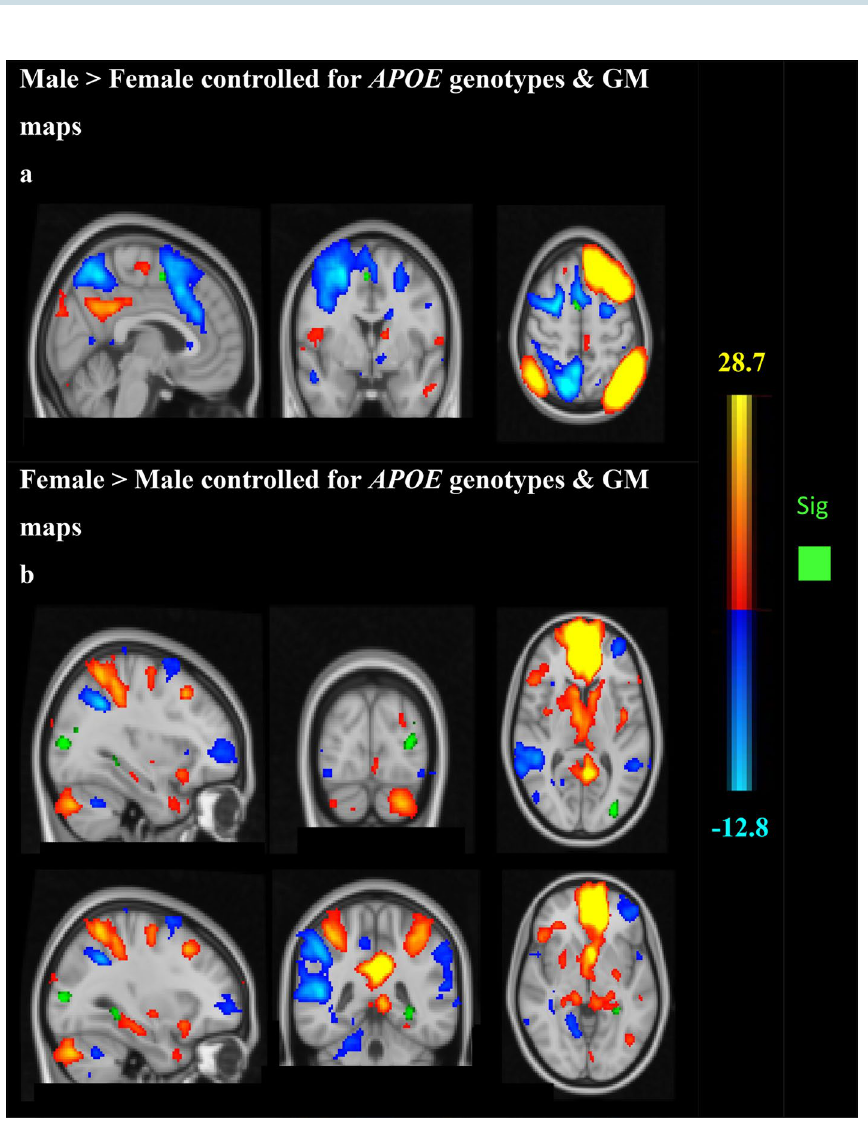
Figure 2. Group-ICA components of the DMN/dorsal–ventral stream and DMN/executive function network. ( a ) Males demonstrating stronger functional connectivity than females between the DMN/dorsal ventral stream (red-yellow/blue) and Juxtapositional lobule cortex (green) ( p < 0.05 family-wise error [FWE]-corrected). Montreal Neurological Institute (MNI) coordinates x = 4, y = 0, z = 54. ( b ). Females showed stronger functional connectivity between the DMN/executive network (red-yellow/blue) and the lateral occipital cortex (superior & inferior divisions) (x = − 32, y = − 86, z = 8) and the parahippocampal region (x = − 30, y = − 42, z = −